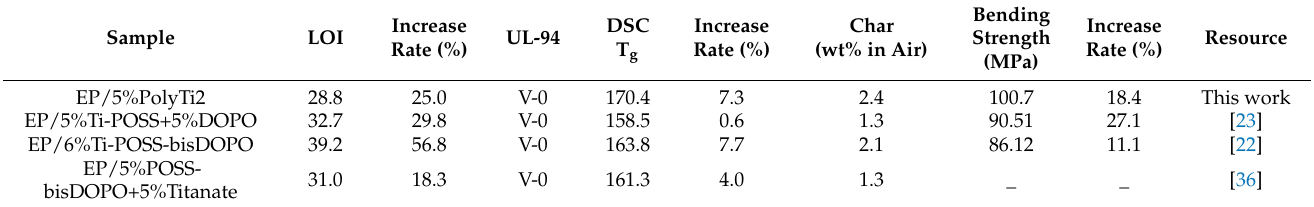
Table 6. The comparison of several flame retardant system for the modification of epoxy